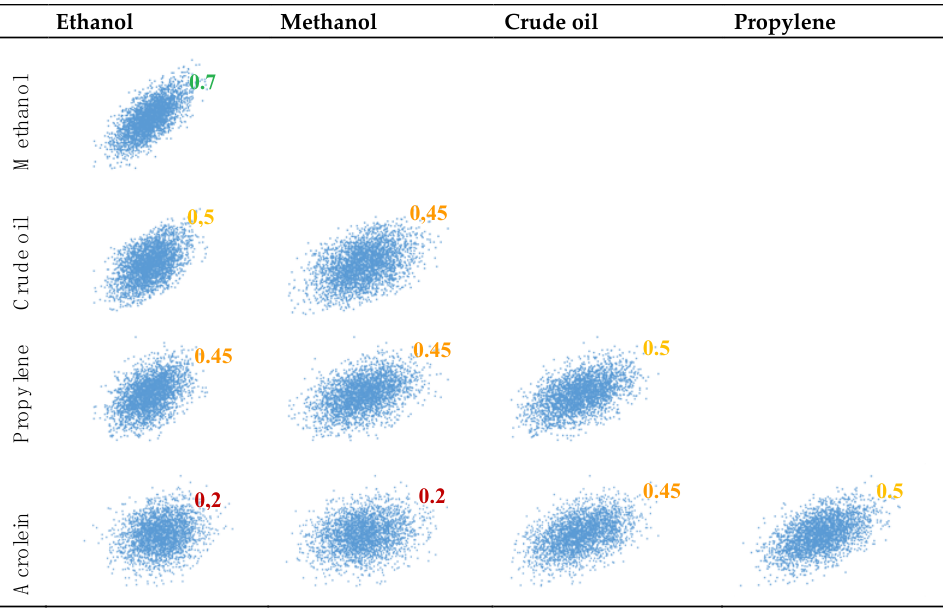
Figure 14. Visualization of the correlated prices of raw materials and products based on our vision of the future. For acrolein, due to limited data, the historical correlations of acrolein/methanol and acrolein/ethanol for small and big plants are probably not relevant (0.2 and 0.001 for the big, and 0.5 and 0.45 for the small plants, respectively). For this reason, bridging through propylene and crude oil, we assumed an acrolein/methanol and acrolein/ethanol correlation coefficient of 0.2 in the future. The correlation matrix is reported in Table